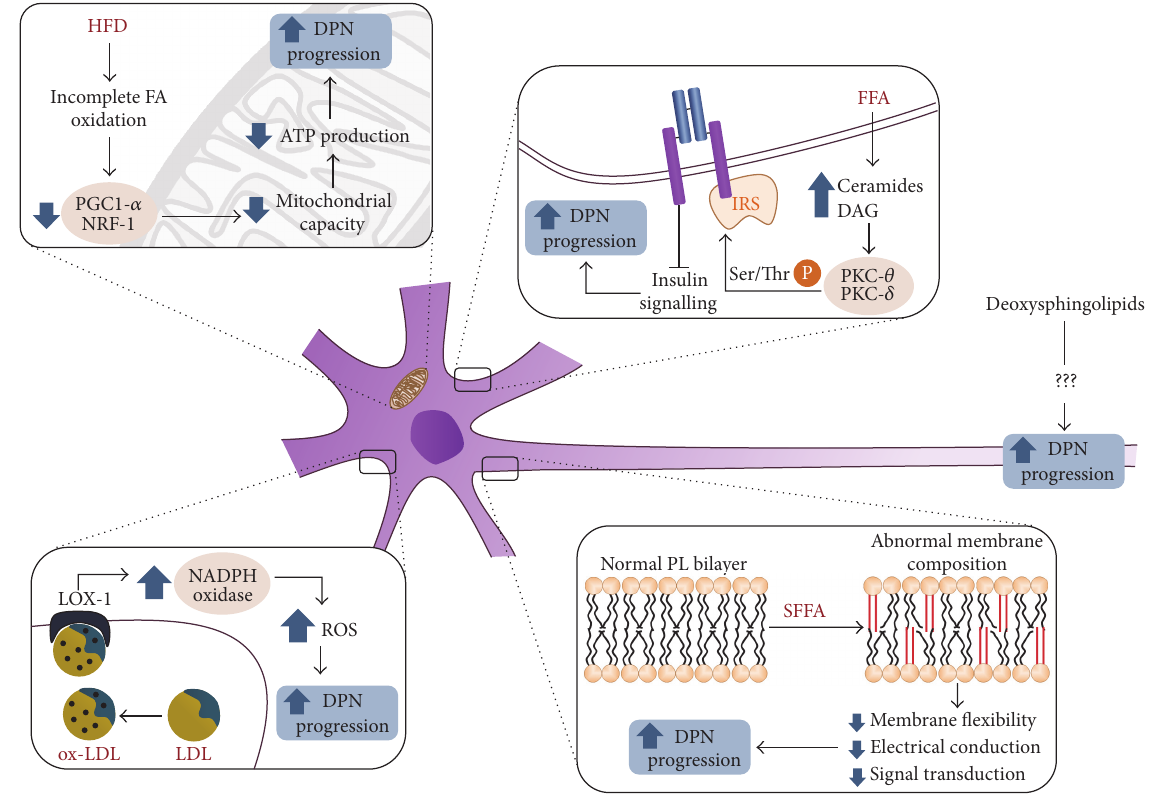
Figure 1: Pathogenic mechanisms linking abnormal lipid metabolism to progression of diabetic neuropathy. HFD: high-fat diet, FA: fatty acids, PGC-1alpha: PPAR-gamma coactivator 1-alpha, NRF-1: nuclear respiratory factor-1, DPN: diabetic polyneuropathy, FFA: free fatty acids, IRS: insulin receptor substrates, PKC-theta: protein kinase C, theta isoform, PKC-delta: protein kinase C, delta isoform, Ser/ThrP: phosphorylation in serine or threonine, ox-LDL: oxidized LDL, LOX-1: lectin-like oxidized LDL receptor, NADPH oxidase: reduced nicotinamide-adenine dinucleotide phosphate oxidase, PL: phospholipid, and SFFA: saturated free fatty acids. Insulin resistance or a high-fat diet increase the cellular supply of FFA, leading to decreased expression of PGC-1alpha and NRF1-alpha-responsive genes and subsequently to impaired mitochondrial capacity and nerve dysfunction. Increased supply of FFA also causes uncontrolled formation of DAG and ceramides, which activate atypical PKC isoforms and promote serine/threonine phosphorylation of IRS, decreased insulin signaling, and defective nerve growth and repair. Theaugmented availability of SFFA ininsulinresistanceleads to changes in thefattyacid composition ofplasma membrane phospholipids. Membranes richer in saturated FA are more rigid and exhibit disturbances of electrical conduction and a reduced capacity for receptor expression and signal transduction, all of which worsen DPN. Accelerated ROS production in diabetes generates oxLDL that bind to the LOX-1 receptor and activate NADPH oxidase, worsening ROS production even further and hastening the progression of DPN. Finally, oxidized deoxysphingolipids are neurotoxic lipids associated with DPN, but their mechanism of action is still